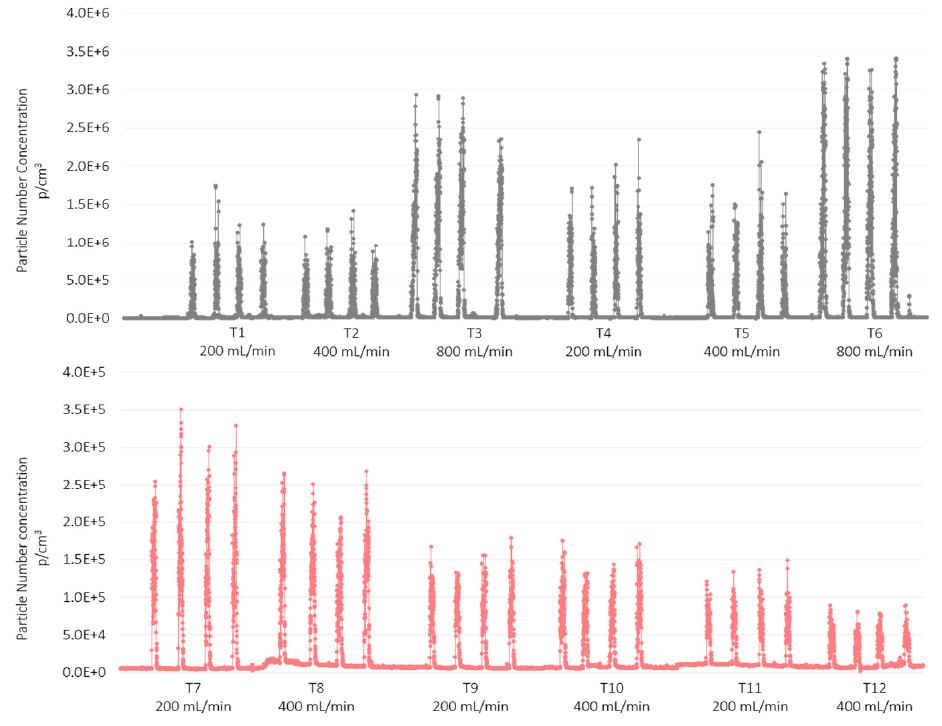
Figure 2. Particle number concentration measured inside the spray chamber with the DiSCmini. Size range: 0.03–0.4 µm- TiO 2 -N solution in grey; AgHEC in pink. Particle size distribution inside the spray chamber, obtained with the SPS30 (4 size classes: 0.5–1 µm; 1.0–2.5 µm; 2.5–4 µm; 4–10 µm) is shown in Figure 3 for TiO 2 -N (grey) and for AgHEC (pink). The 0.5–1.0 µm size range of the UFPs concentration was observed to be lower for the TiO 2 -N suspension. Comparison between SPS30_L and SPS30_R showed a relative difference in particle number concentration of about 20% with one or four operating nozzles, while in the two-nozzle configuration, the concentration on the left side of the chamber was higher than on the right (about 70%).